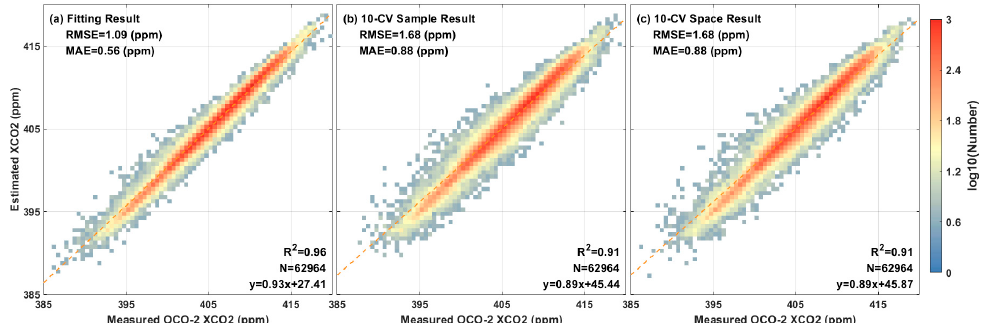
Figure 6. Scatter density plot of ( a ) direct fitting, ( b ) sample-based cross-validation, and ( c ) spatial cross-validation.